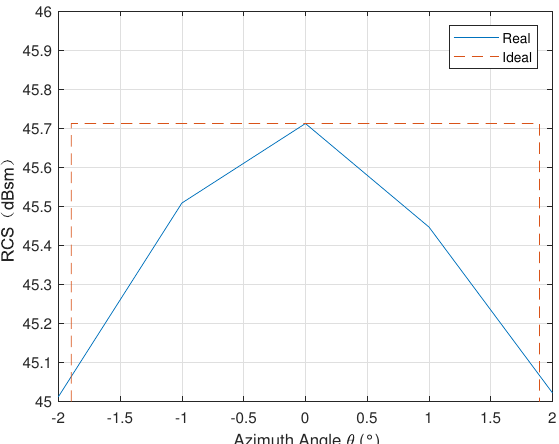
Figure 6. The partial azimuth RCS pattern in the case of alignment ( θ = 0 ◦